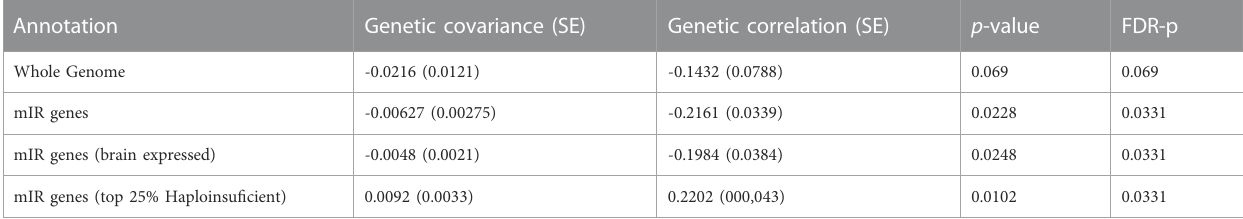
TABLE 2 Genetic covariance analysis between Autism and Epilepsy across whole genome and within target genes of miRNAs dysregulated in both conditions. Whole genome and partial covariances were performed with LD Score Regression (LDSC) and GNOVA, respectively, following the recommended settings (see methods). p -values were corrected with Benjamini – Hochberg FDR to control for multiple testing. Brain expressed genes in any GTEx v7 brain tissue were considered in “ brain expressed ” annotation. Genes belonging to the top 25% with the highest haploinsuf fi ciency score from Decipher predictions were used as haploinsuf fi cient